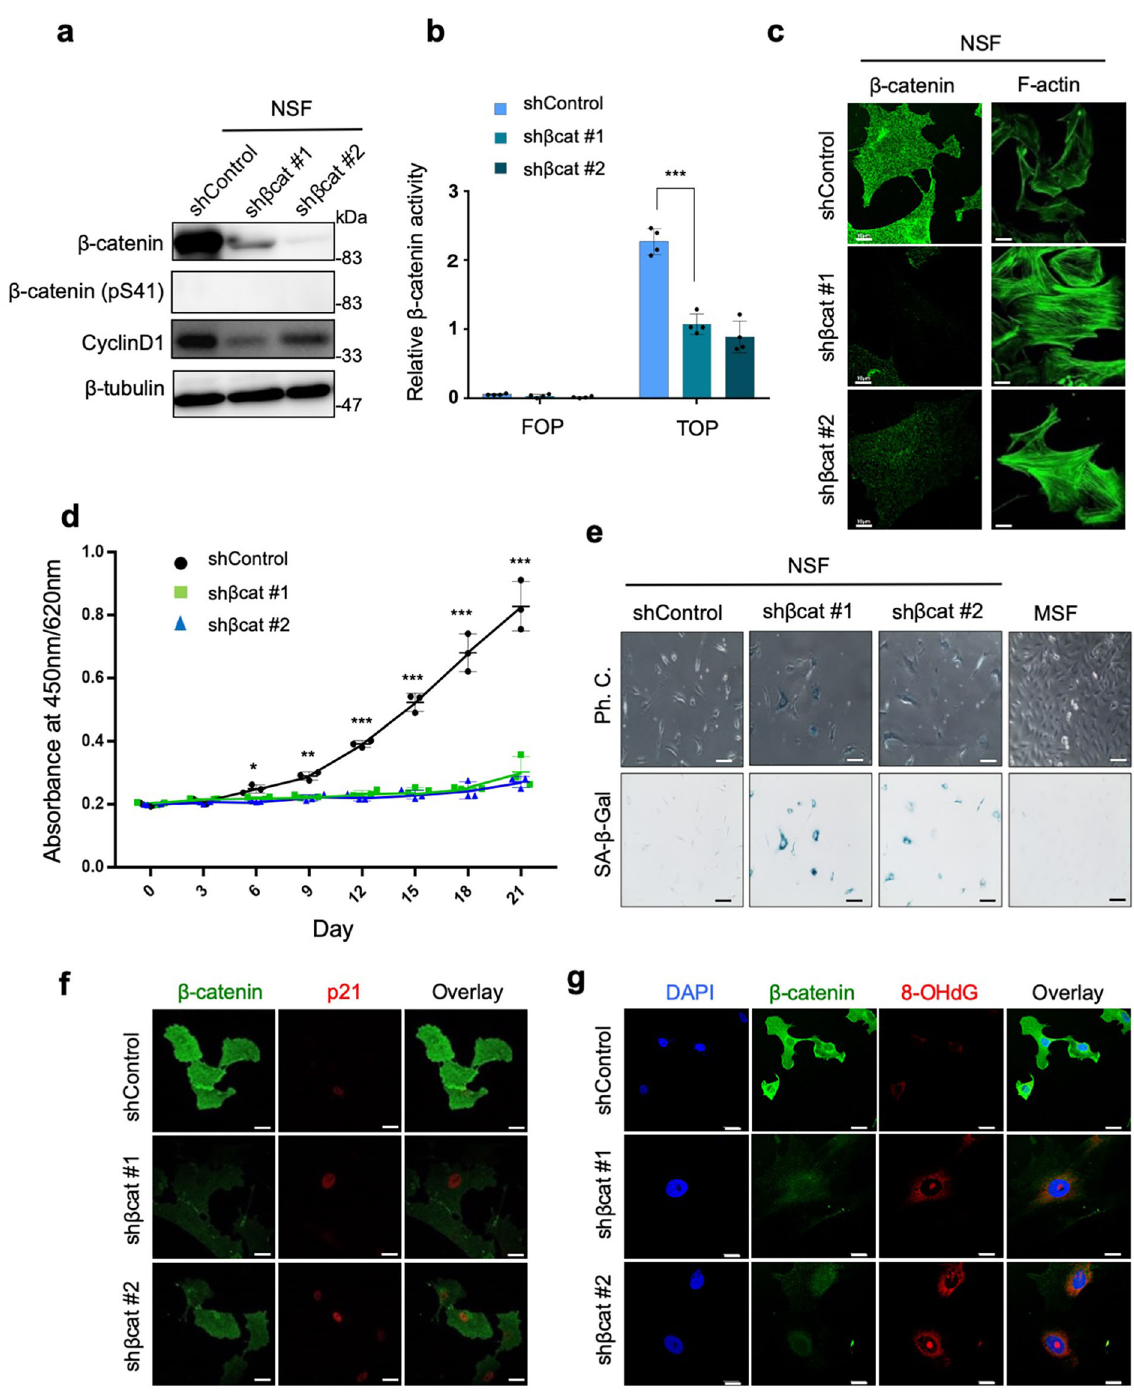
Fig. 2 β -catenin knockdown induces senescence-like phenotypic changes in NSFs. a Immunoblots showing changes in expression of components of the β -catenin pathway after β -catenin knockdown in NSFs. β -tubulin was used as a loading control. b TOPFLASH assay showing relative β -catenin activity of NMR skin fi broblasts (NSFs) after β -catenin knockdown. c Morphological changes in NSFs caused by β -catenin knockdown. Scale bars, 10 μ m. d Proliferation rates of NSFs and their β -catenin knockdown counterparts were determined in a growth assay. Data presented in b and d are expressed as the mean ± standard deviation ( n = 4); *** P < 0.001, two-sided Student ’ s t test. e Representative images showing SA- β -gal activity in control NSFs, β -catenin knockdown NSFs, and MSFs (Left). Quantitative analysis of SA- β -Gal activity in control NSFs and β -catenin knockdown NSFs (Right). Data are expressed as the mean ± standard deviation ( n = 4 biologically independent experiments) (lower graph); *** P < 0.001, two-sided Student ’ s t test. f Immuno fl uorescence staining of β -catenin (green) and p21 (red) in control NSFs and β -catenin knockdown NSFs. g Immuno fl uorescence staining of β -catenin (green) and 8-OHdG (red) in control and β -catenin knockdown NSFs. Scale bar, 20 μ